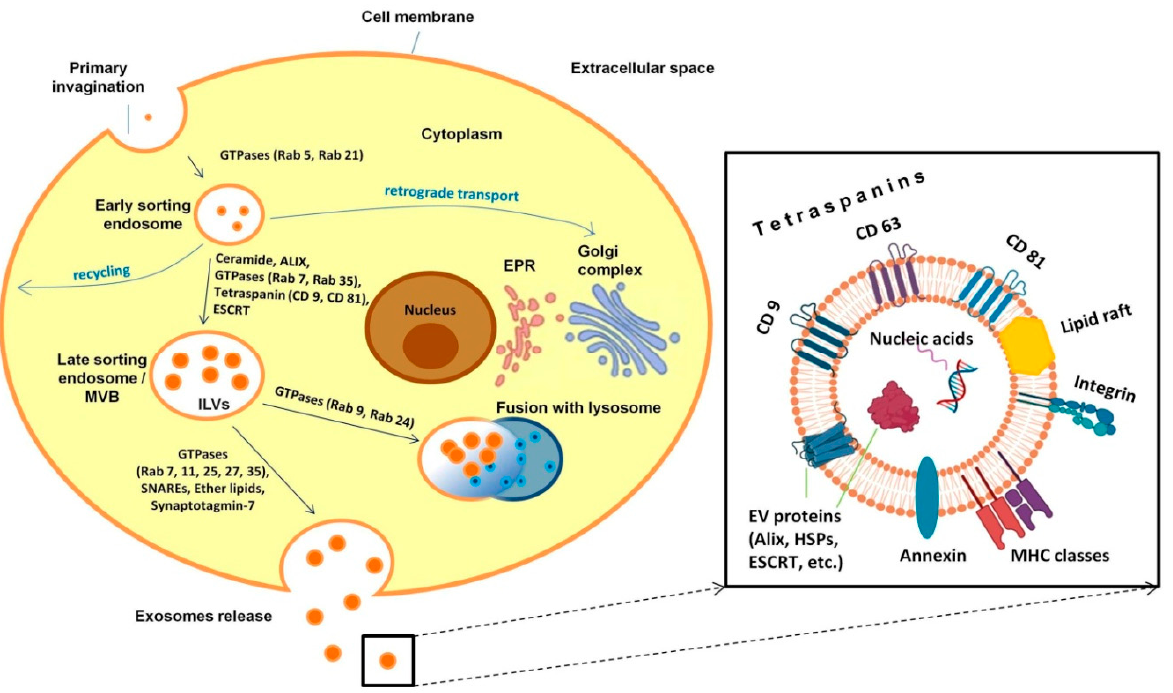
Figure 1. Schematic presentation of exosome formation, release and molecular composition. The early sorting endosome forms as a result of primary invagination under the control of GTPases, including Rab5 and Rab21. The maturation of an early endosome into a late sorting endosome involves such factors as ceramides, ALIX, Rab7, Rab35, tetraspanins (CD9 and CD81), as well as endosomal sorting complexes required for transport. The fusion of multivesicular bodies with lysosomes and their degradation occurs under the control of the GTPases Rab9 and Rab24. The fusion of multivesicular bodies with the cell membrane followed by the release of exosomes into the extracellular space is mediated by Rab family GTPases, SNAREs (soluble NSF attachment receptors) and other elements. Mature exosomes are spherical formations surrounded by a two-layer lipid membrane enriched with ceramides, cholesterol, sphingomyelin, phosphatidylserine and glycosphin- golipids. The exosome molecular cargo can include various families of proteins, adhesion molecules, receptors, various RNAs and DNA fragments. ILVs—intraluminal vesicles, MVBs—multivesicular bodies, EPR—endoplasmic reticulum, ESCRT—endosomal sorting complexes required for transport, SNAREs—soluble N-ethylmaleimide-sensitive factor attachment protein receptors, HSPs—heat shock proteins, MHC—major histocompatibility